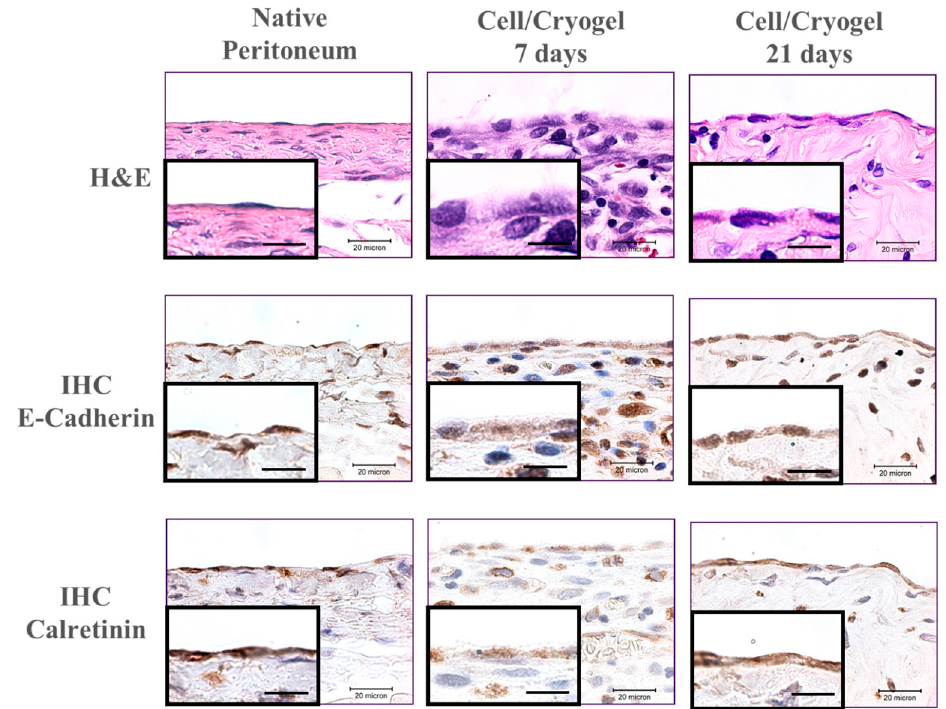
Figure 8. Gross view of the initial mesothelium wound and the transplanted cell / sca ff old constructs at di ff erent time points post-implantation.